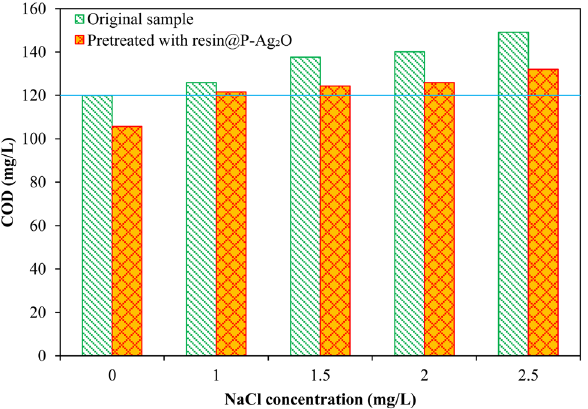
Figure 9. Effect of NaCl concentration to COD value of wastewater with and without using Ag 2 O/cation resin material to remove the